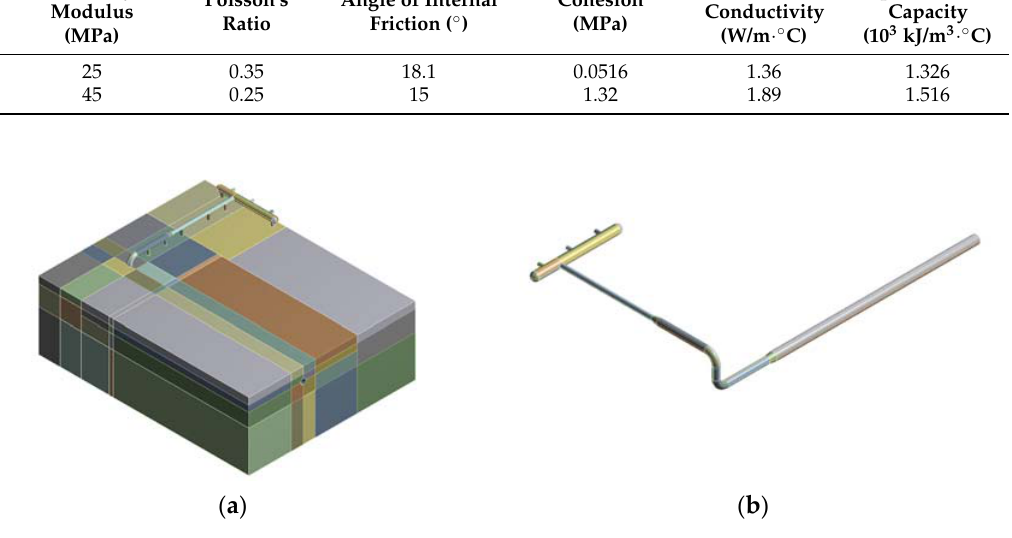
Figure 5. Element model diagram: ( a ) Overall model diagram; ( b ) piping model diagram. Table 1. Basic physical parameters of soils.